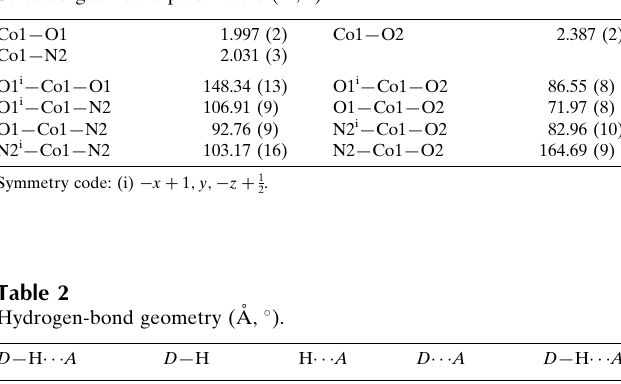
Selected geometric parameters (A˚ , (cid:2) ).